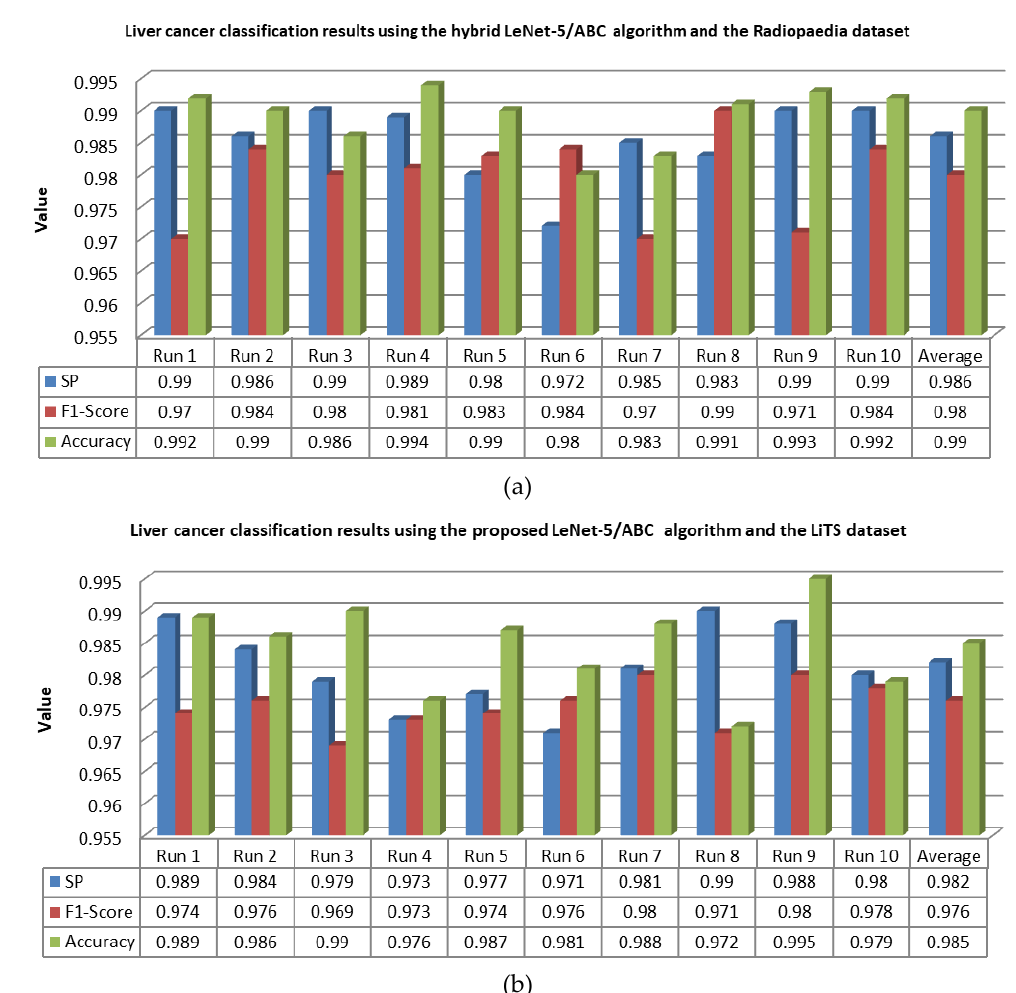
Figure 13. Classification results of liver lesions obtained over 10 runs of the proposed LeNet-5/ABC algorithm, in terms of specificity (SP), F1-score, and accuracy. Results are demonstrated using the ( a ) Radiopaedia dataset and ( b ) LiTS dataset.